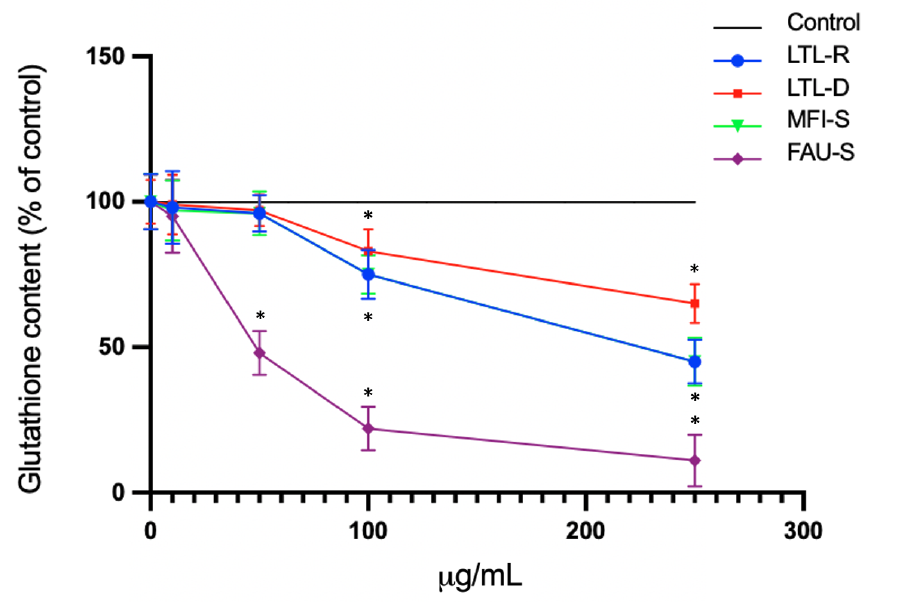
Figure 7. Effect of zeolites on GSH levels in lung fibroblast (IMR-90 cells). Cells were treated with zeolite LTL-R, LTL-D, MFI-S, FAU-S for 72 h. At the end of the exposure, cells were washed with PBS, and GSH (control: 61 ± 5 nmol/mg protein). Control cells cultured in zeolite-free media were run in parallel to treatment groups. The data are expressed as mean ± SD of three independent experiments. ∗ indicates a statistically significant difference compared to controls ( p <